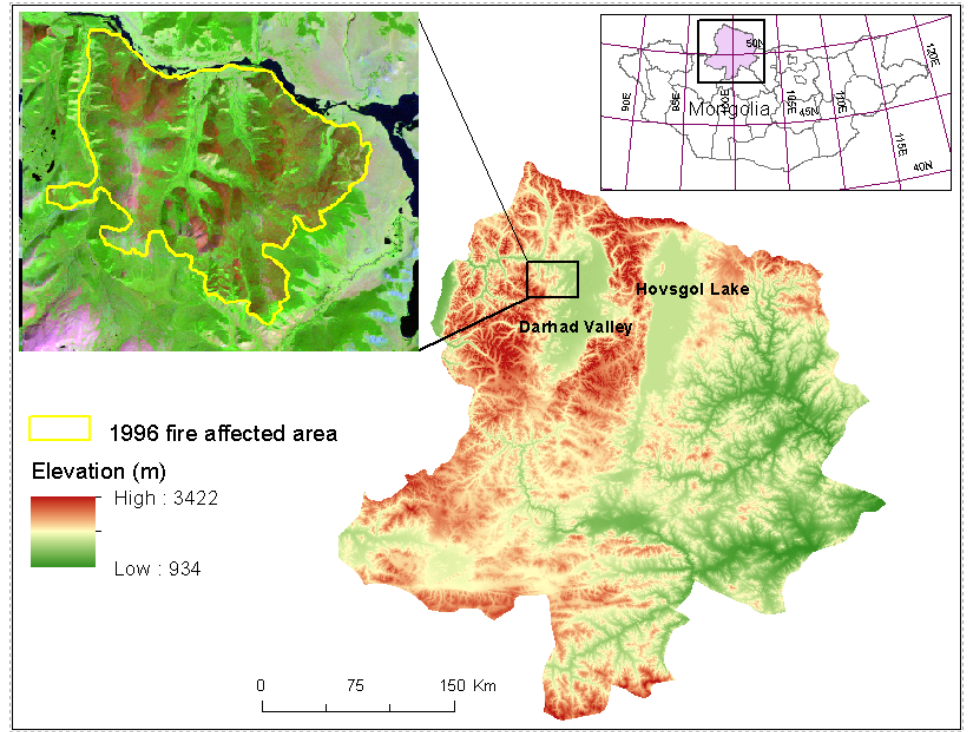
Figure 1. The study area. The 1996 fire affected area (top left corner) was overlaid on the 1998 Landsat TM image (R:G:B =